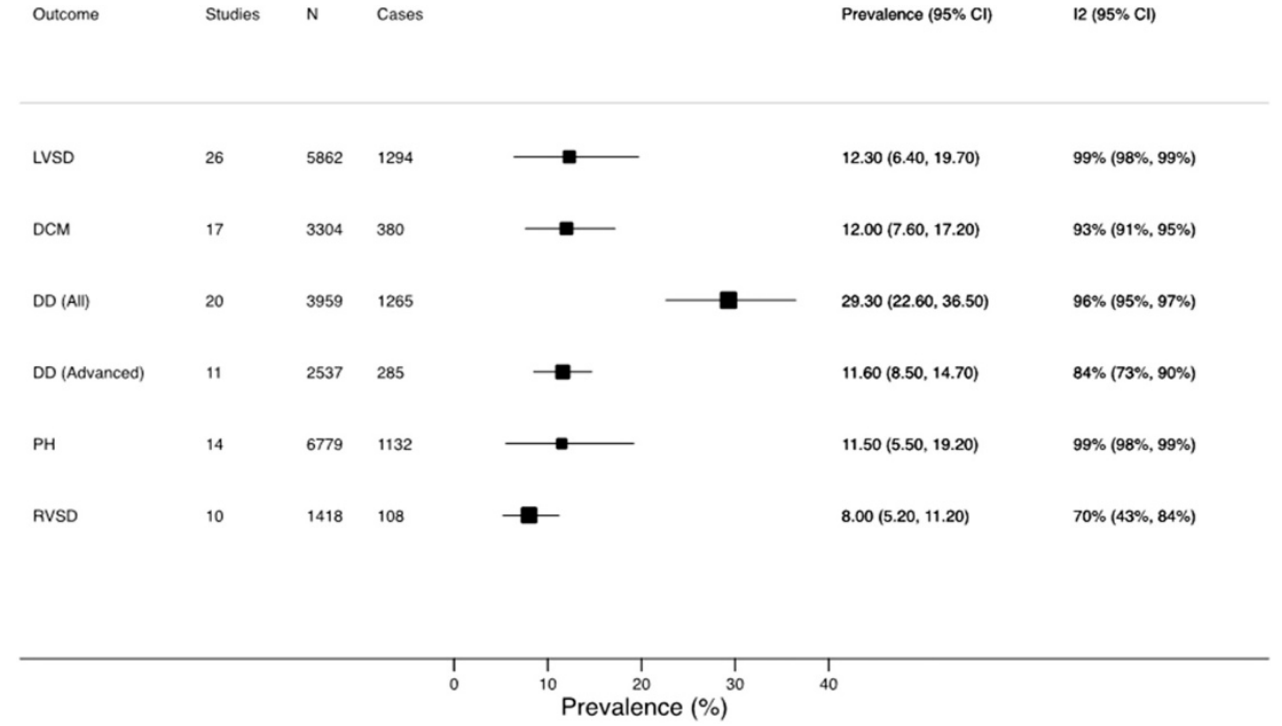
Figure 1. Pooled prevalence of cardiac impairment in adults with HIV infection. Reproduced with